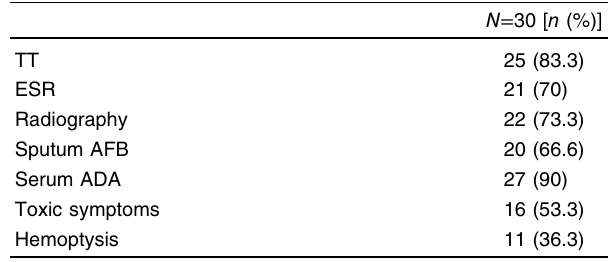
The best cut-off value obtained from the receiver operator characteristic curve method for serum ADA was 30.15. At this point the sensitivity was 95% and specificity was 86.7%, with a positive predictive value of 90.5%, negative predictive value of 92.9%, and accuracy of 91.4%. ADA, adenosine deaminase; AUC, area under the curve; NPV, negative predictive value; PPV, positive predictive value.